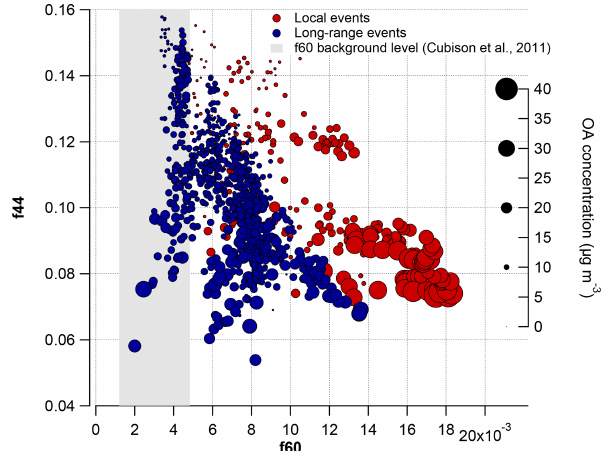
Figure 9. f 44 vs. f 60 ratios during the local events (dark red circles) and the long-range events (dark blue circles). The size of markers is proportional to the OA concentration. The grey area represents the f 60 background level defined by Cubison et al. (2011) (0.003 ± 3 times the standard